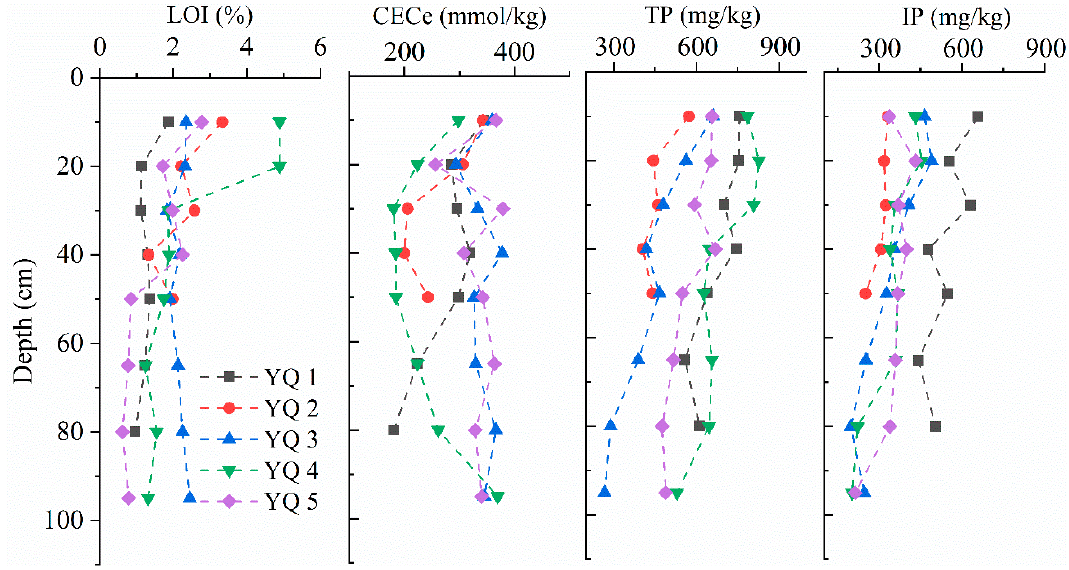
Figure 3. The vertical variation of LOI, CECe, TP, and IP at four sites.